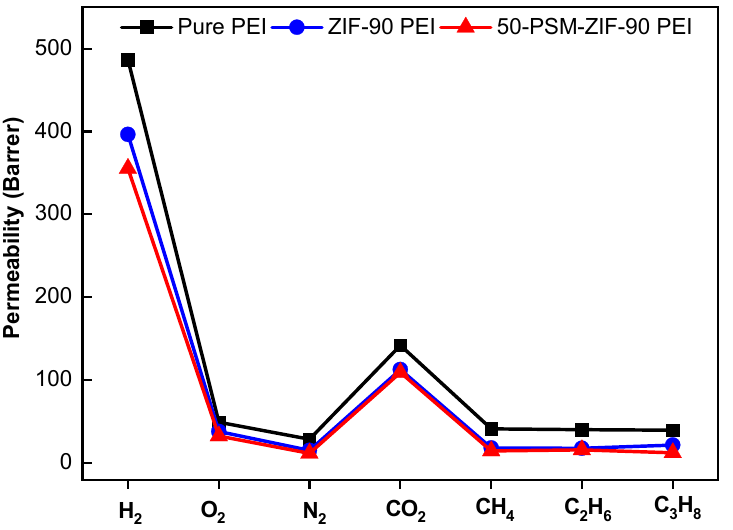
Figure 13. Pure gas permeability of Pure PEI membrane, ZIF-90 PEI and 50-PMS-ZIF-90-PEI membranes.